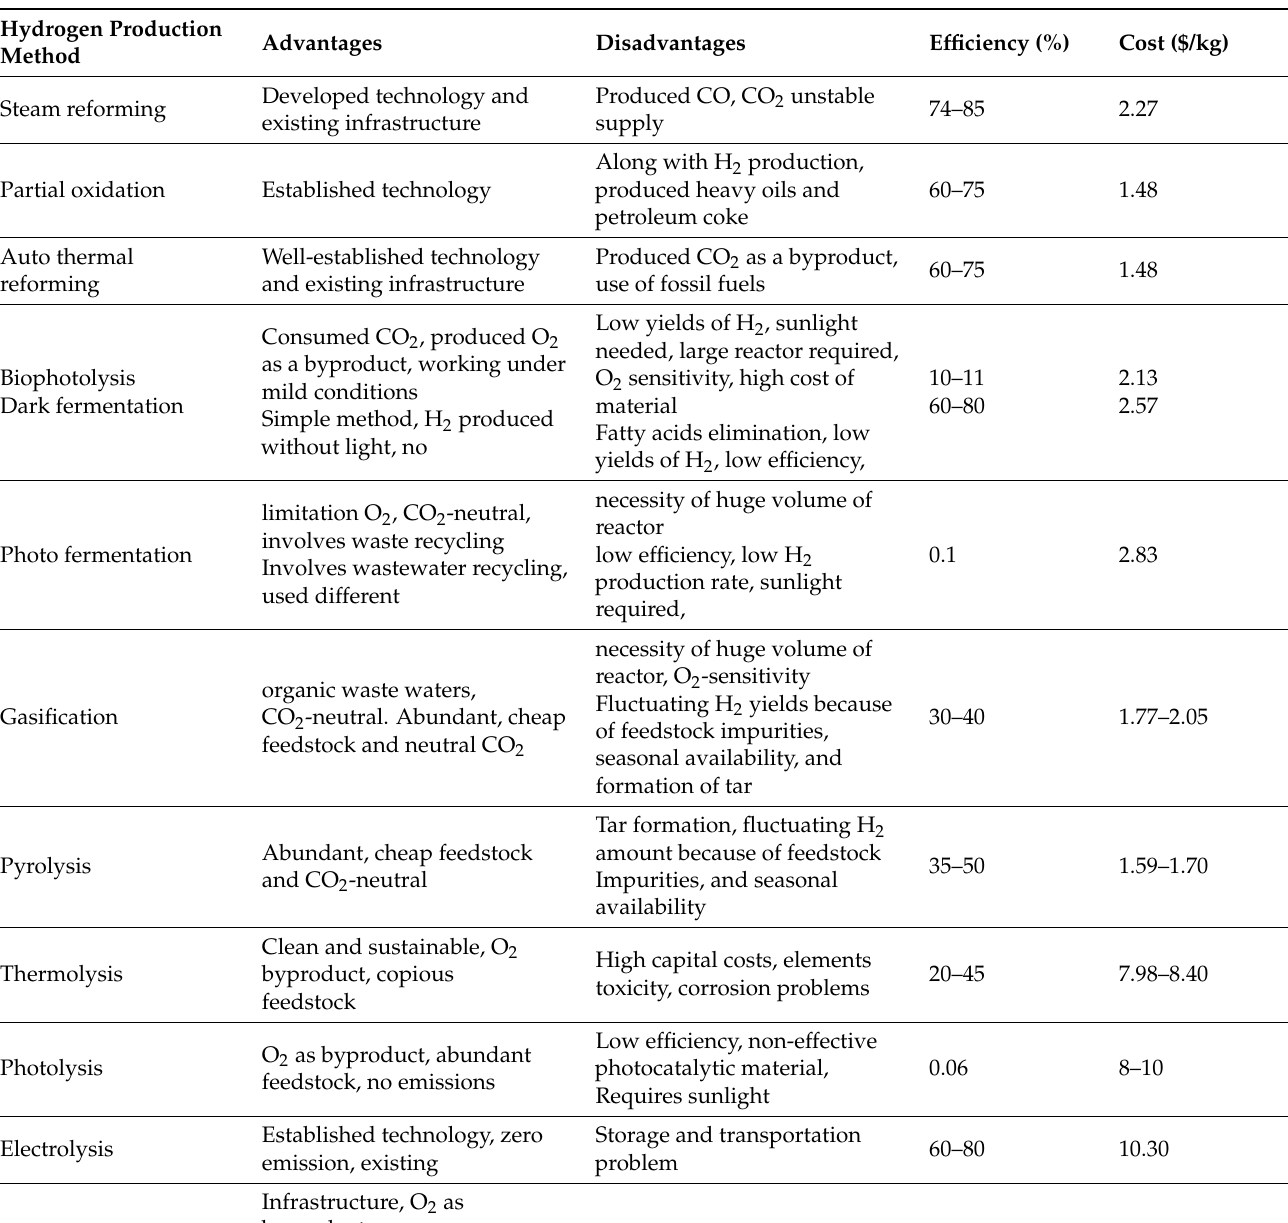
Table 1. Hydrogen production approaches, comparing efficiency as well as strengths and drawbacks— taken, with permission from